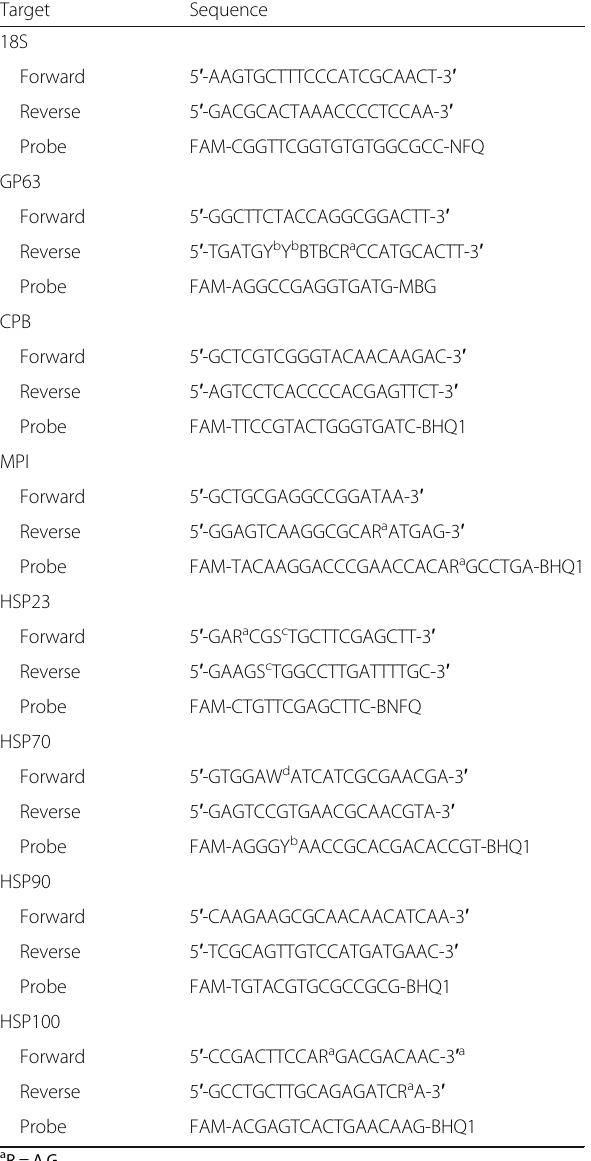
Table 2 Primer and probe sequences used to detect virulence factor RNA transcripts by real-time